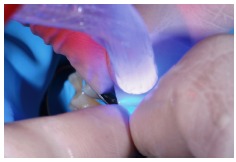
Photopolymerization.